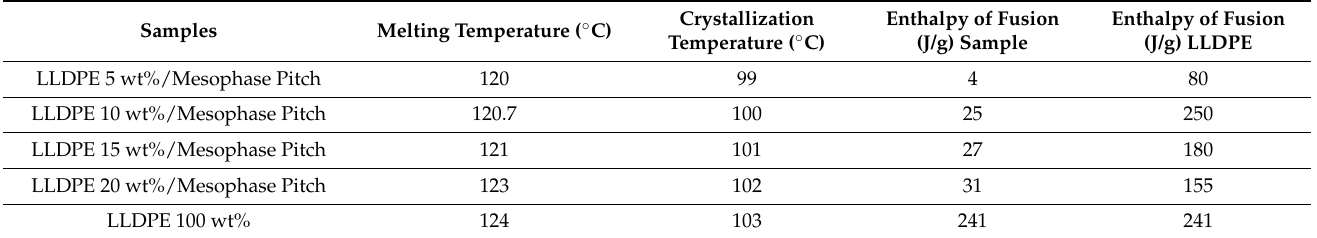
Table 4. Melting and crystallisation temperatures of LLDPE and LLDPE/mesophase pitch blend. Samples Melting Temperature ( ◦ C)